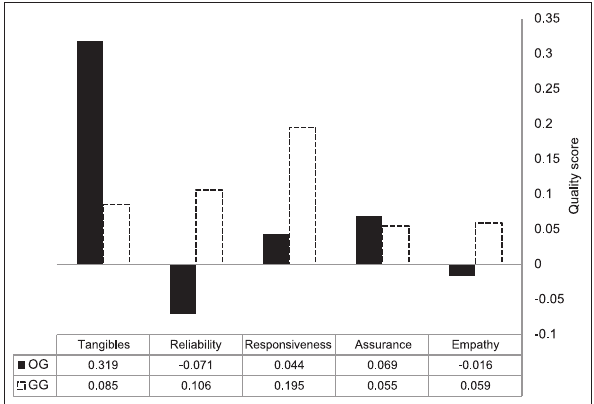
Figure-1: Service quality scores per dimension.